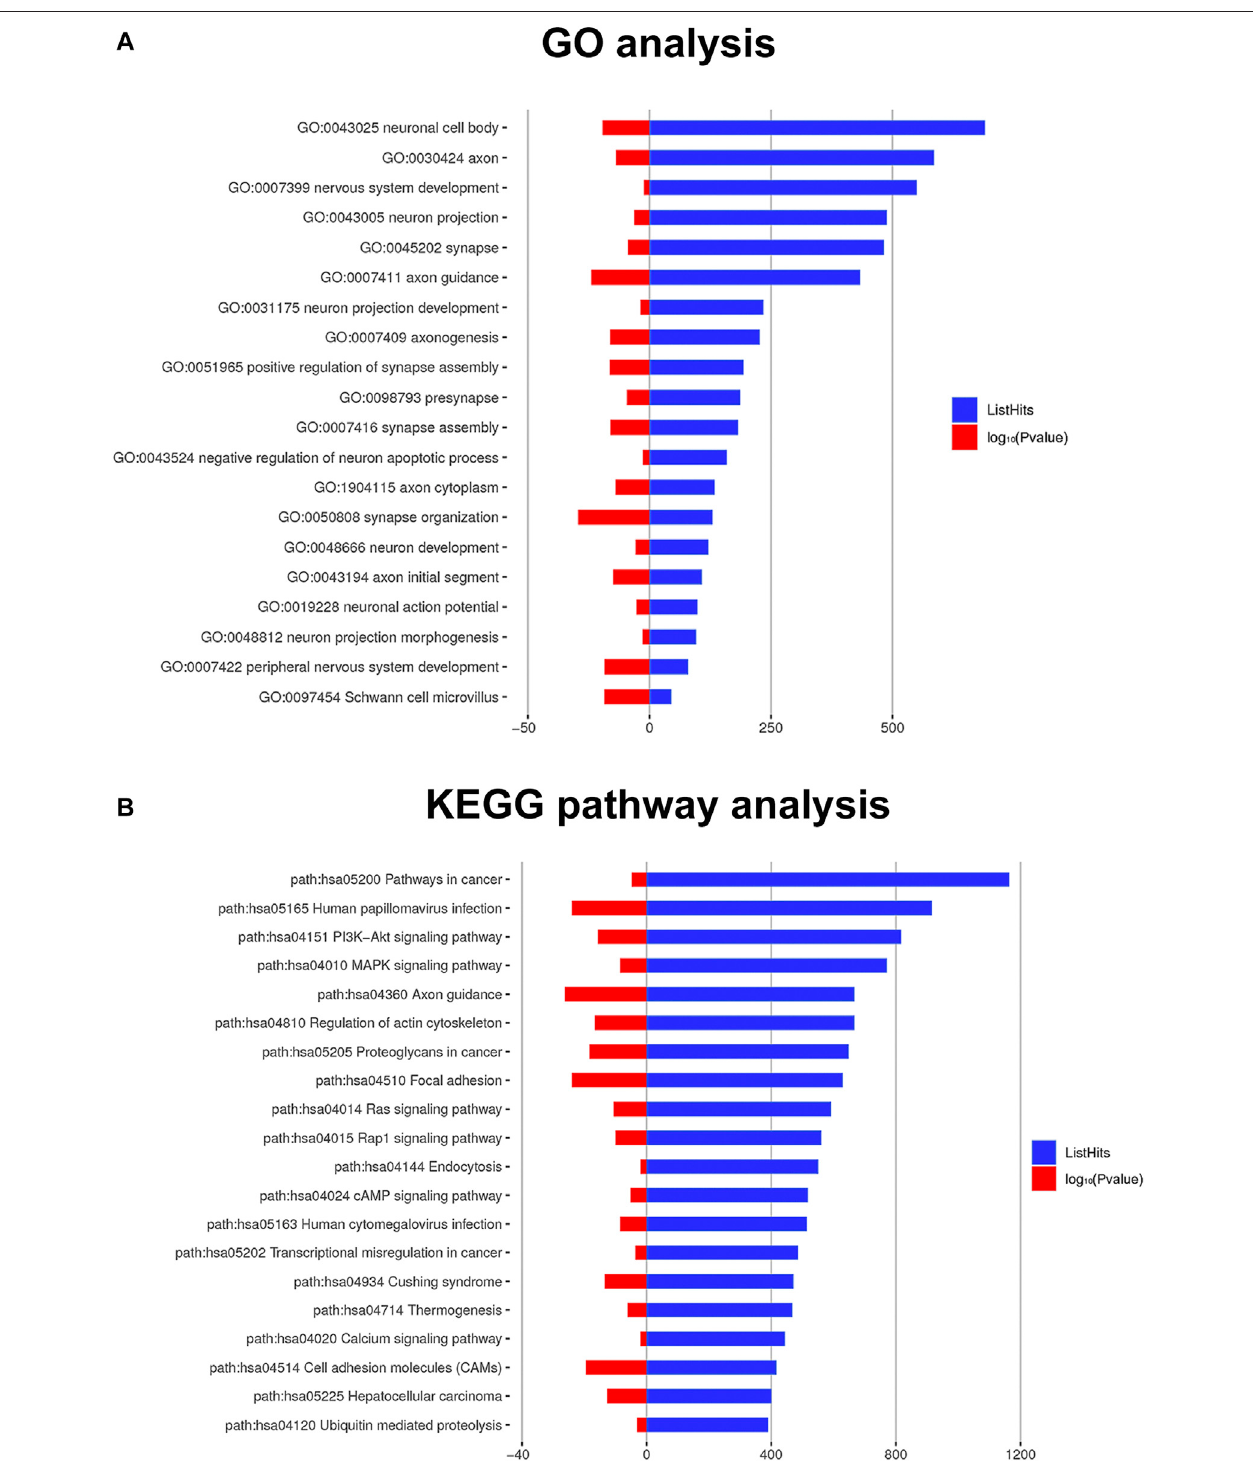
FIGURE 5 | Signi fi cant GO terms and pathways of the target genes. (A) Twenty GO terms related to Schwann cells, neurons and axons are listed. (B) The top 20 signi fi cantKEGGpathway terms sortedbythenumber ofgenes(ListHits). Theblue column represents the ListHits, while thered column representsthe p value(-log10).